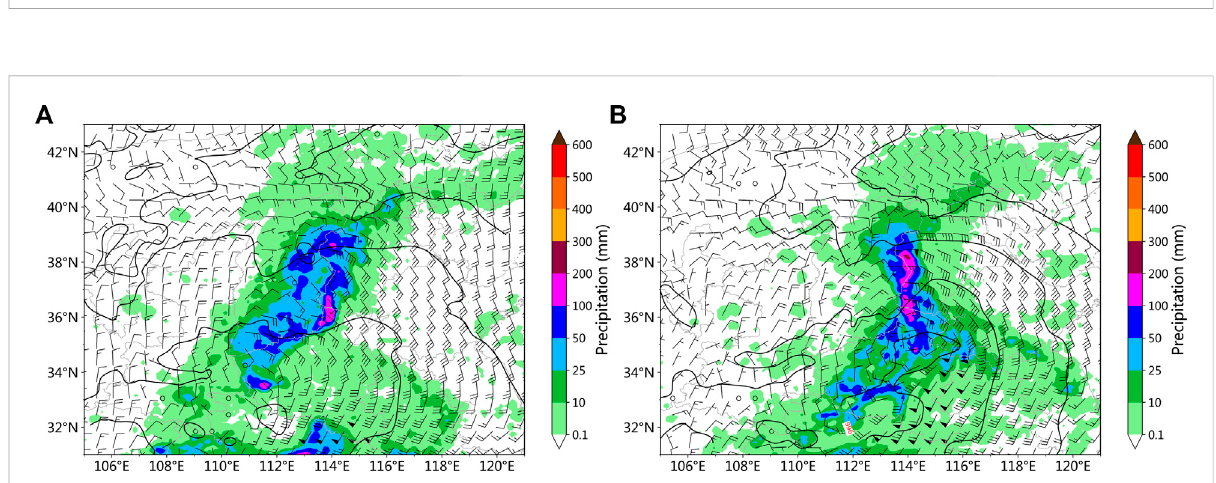
FIGURE 4 Wind fi eldat850 hPaandsea-levelpressure(contourline)at0000UTC (A) and0600UTC (B) on